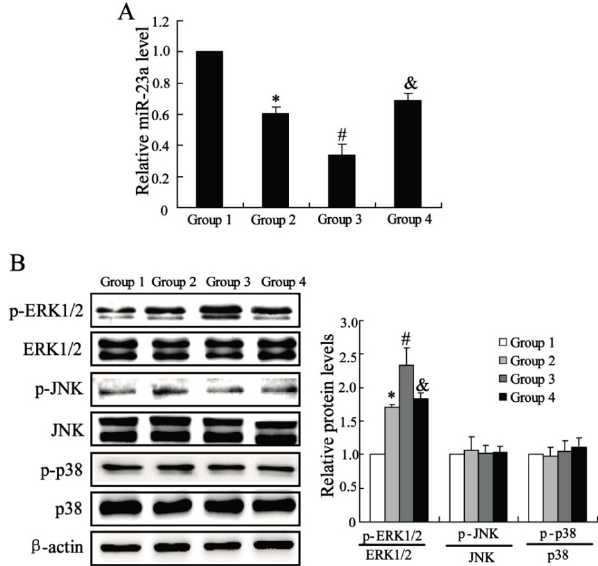
Figure 3. The effects of CXCL13 on miR-23a and mitogen-activated protein kinase (MAPK) molecules expression in vivo. ( A ) The miR-23a expression; ( B ) The protein expression of ERK1/2, JNK and p38. Data were shown as mean ± SD. * vs. Group1 (Injection with medium), p < 0.05; # vs. Group 2 (Injection with MSCs), p < 0.05; and & vs. Group3 (Injection with CXCL13 treated MSCs), p < 0.05. Group 4 is the specimens injected with CXCL13 treated MSCs accompanied by infection with lentiviruses of silencing